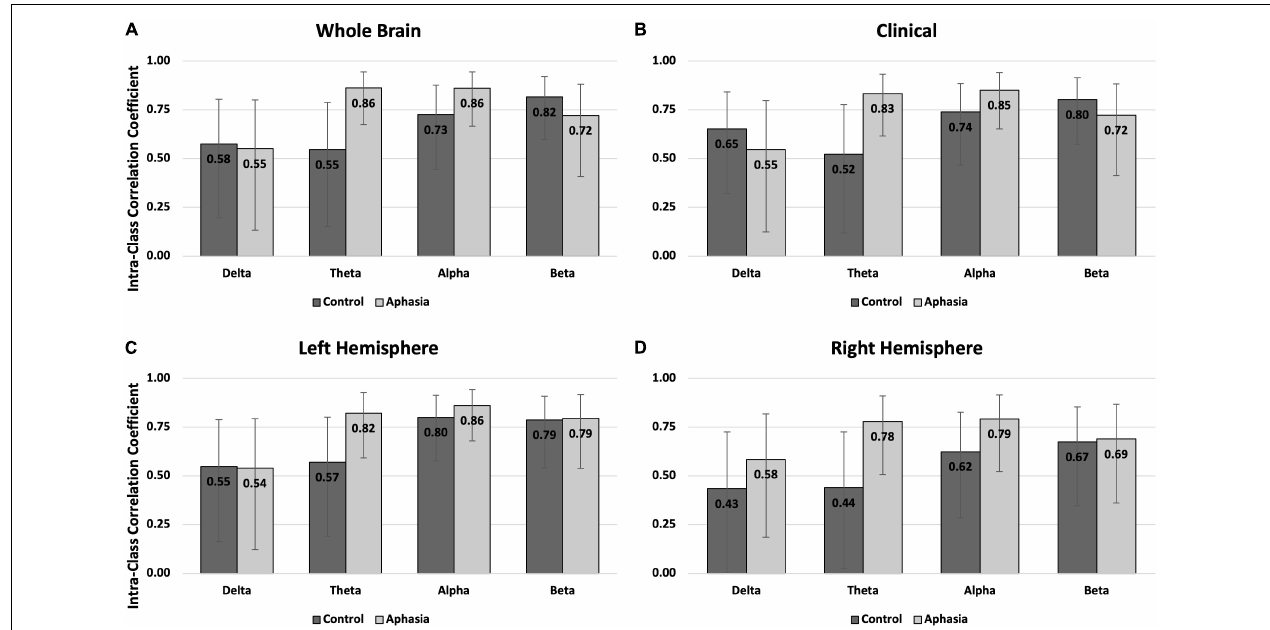
FIGURE 2 | Intra-class correlations by group and frequency band for the eyes open rest condition in (A) the whole brain montage; (B) the clinical montage; (C) the left hemisphere montage; and (D) the right hemisphere montage. Error bars represent the 95% confidence interval of the point estimates reported in Table 3 .